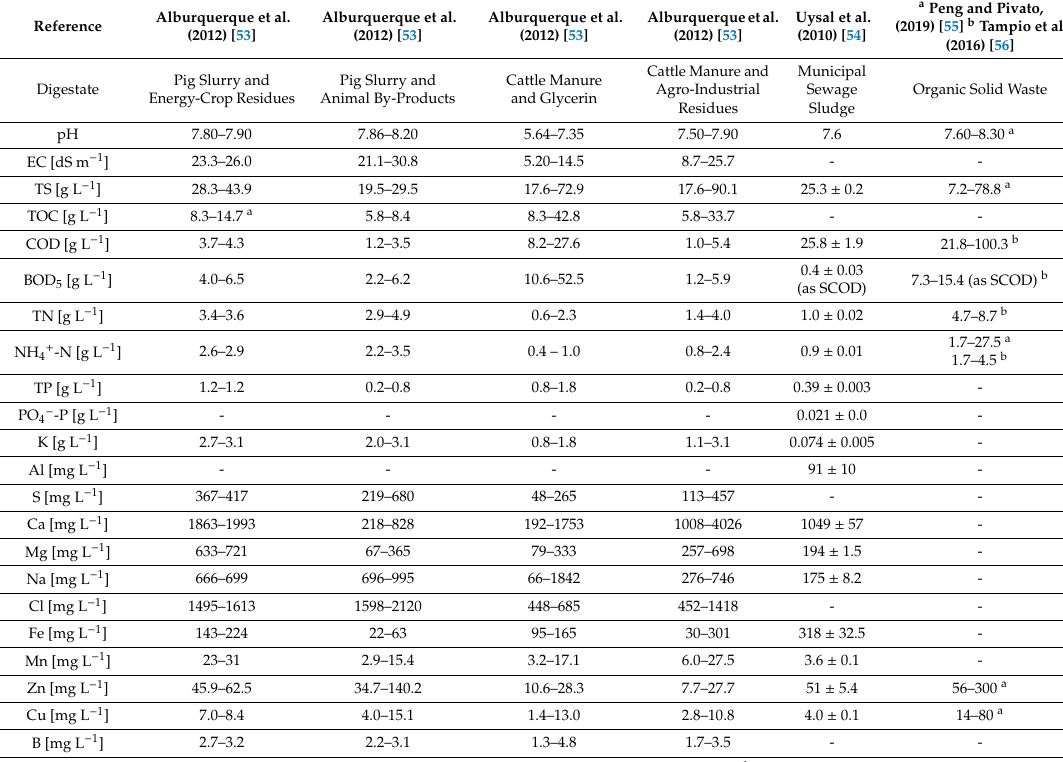
Table 1. Digestate